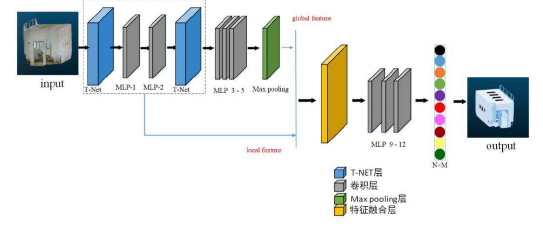
Figure 2. Structure of PointNet